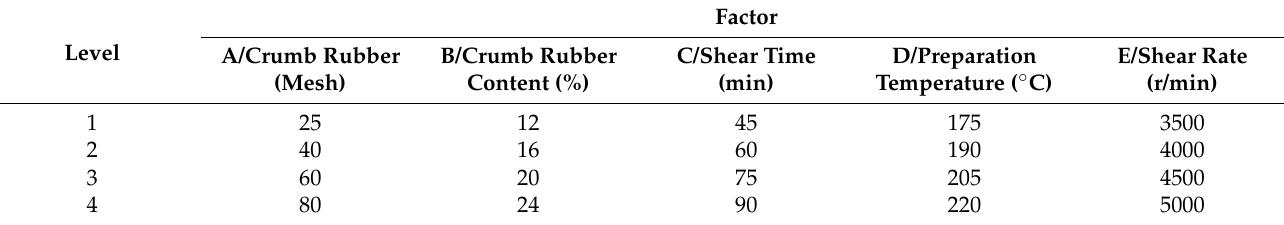
Figure 8. Cone penetration tester. Table 6. Factor and level of orthogonal test.